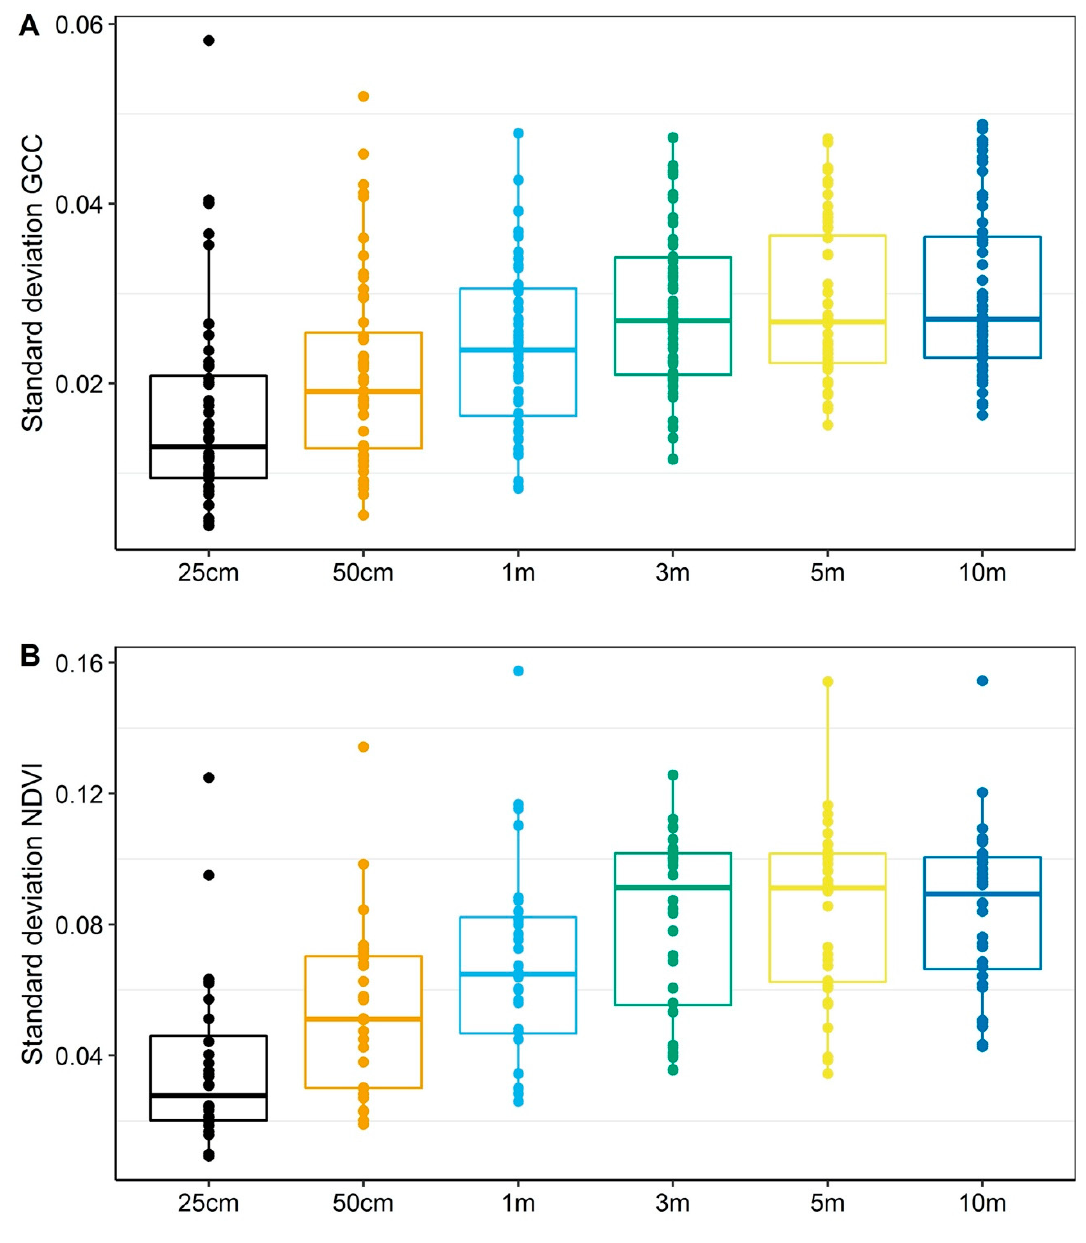
Figure 2. Standard deviations for aggregated means to assess variability in GCC ( A ) and NDVI ( B ) within plots of increasing spatial resolution. For both GCC and NDVI, the standard deviation is smaller for finer spatial resolutions, and increases with increasing spatial resolution till 3-m radius at which point the standard deviations plateau. The plateau indicates that the 3-m, 5-m, and 10-m have comparable variability. The patterns illustrate that GCC and NDVI exhibit similar patterns of heterogeneity.